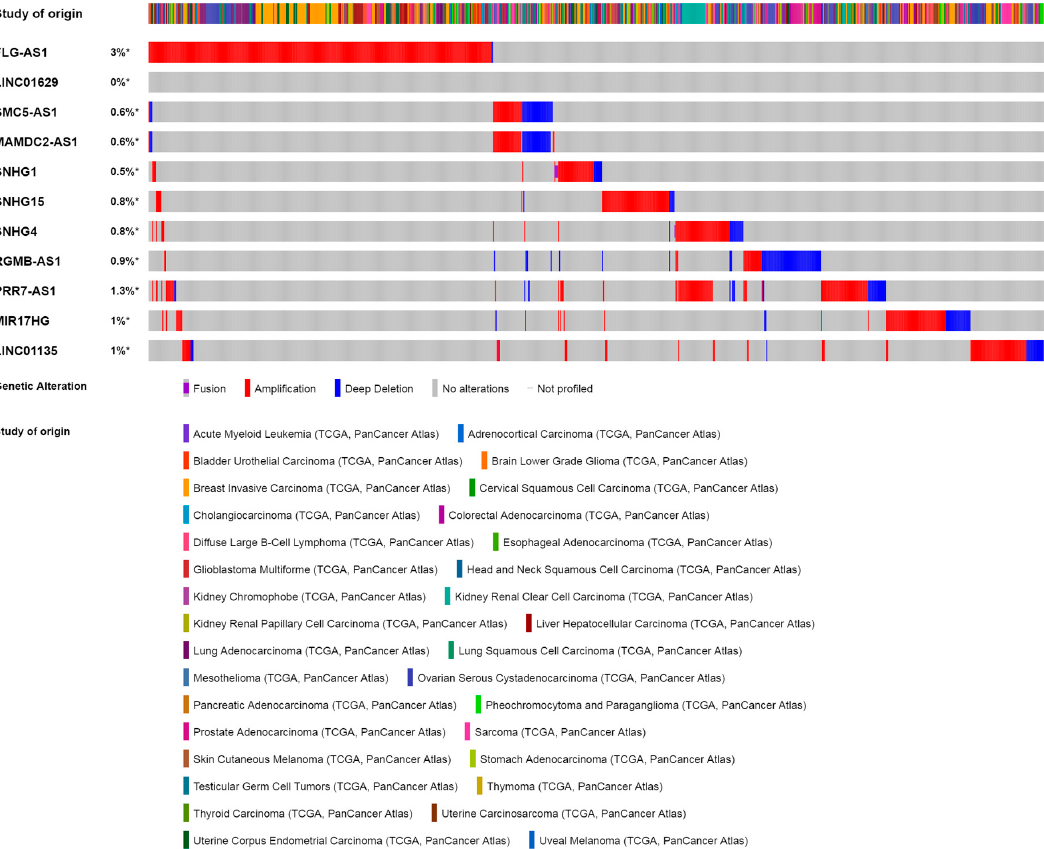
Figure 2. Olaparib-modulated lncRNAs in pan-cancer samples. OncoPrint for olaparib-modulated lncRNAs in the PanCancer Atlas cohort, obtained from cBioPortal. 977 out of 10,967 (9%) cancer samples are altered for one or more of these lncRNAs. * p -value < 0.05.